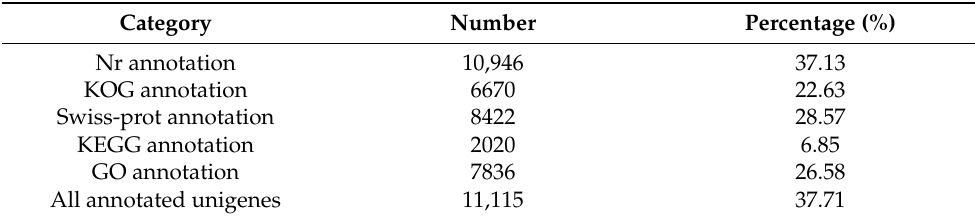
Table 3. Functional annotation of C. macrophyllum in different databases.